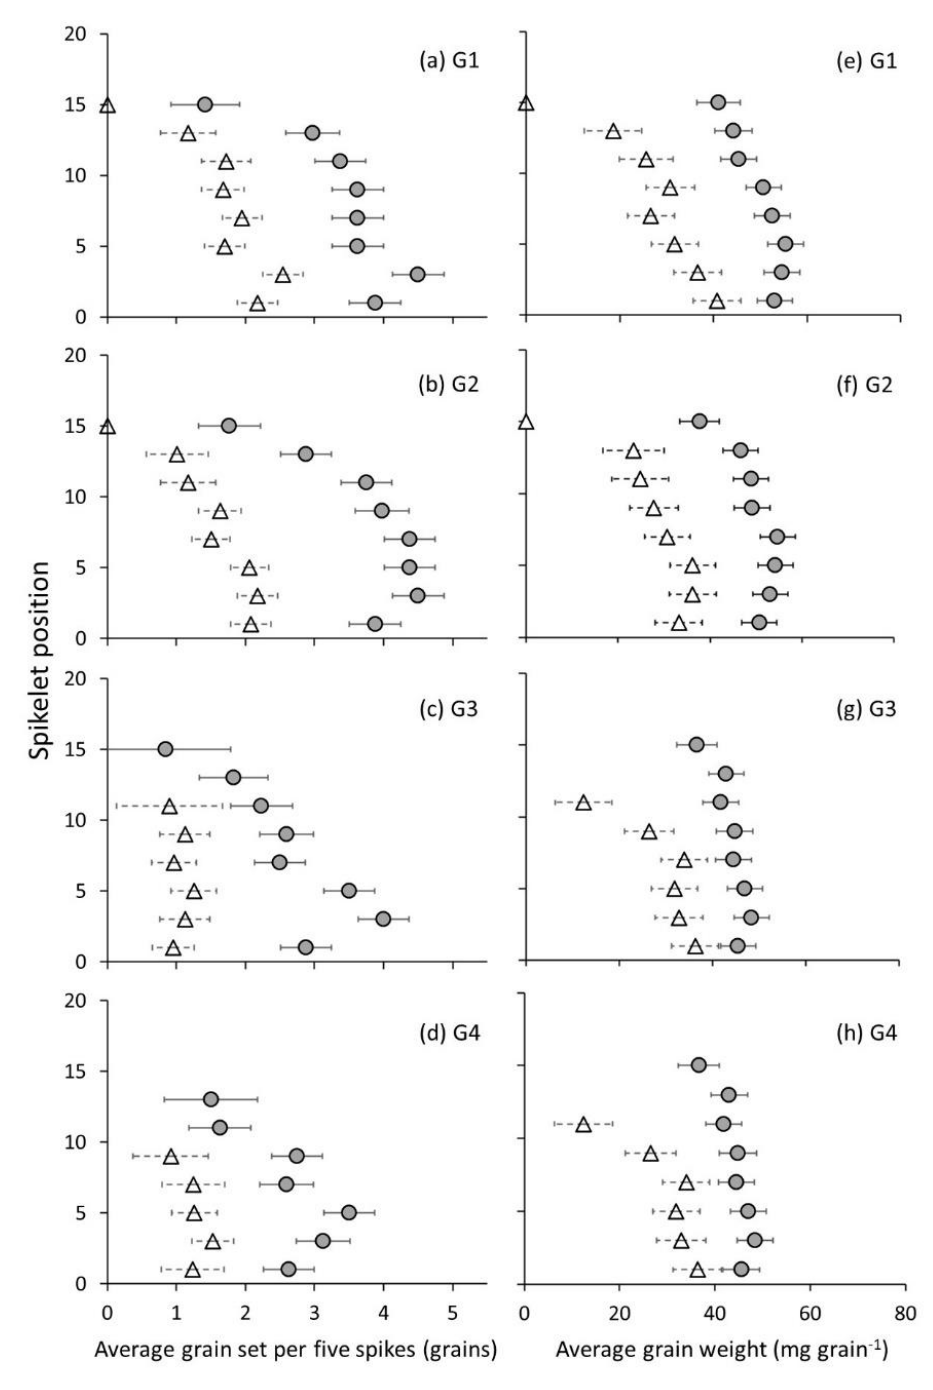
Figure 9. Values are predicted means ( n = 45 spikes per data point) of average grain set and grain weight in heated and non-heated plots at a higher incidence of frost (mid-April 2019, 17 April 2019, Table 1 and Figure 4). Grain set is shown from G1 to G4 ( a – d ) (Figure 3) and average grain weight along the spike in each grain position of the spikelet is shown from G1 to G4 ( e – h ). Heated plot (grey circles) and non-heated plot (white triangles). Horizontal bars are ± standard errors.